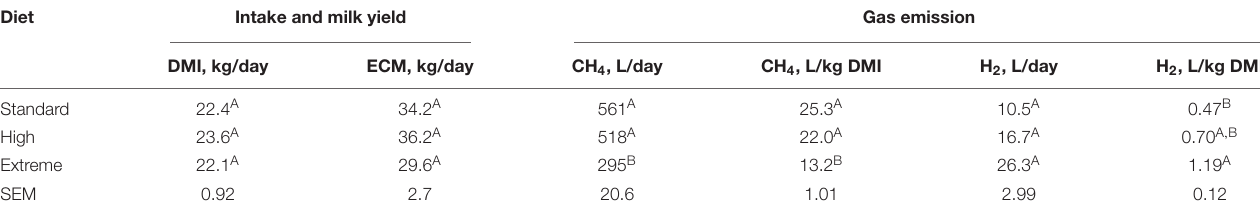
TABLE 1 | Data from in vivo measurements of dry matter intake (DMI), energy-corrected milk (ECM) yield, CH 4 , and H 2 as modified from Olijhoek et al. (2022). Diet